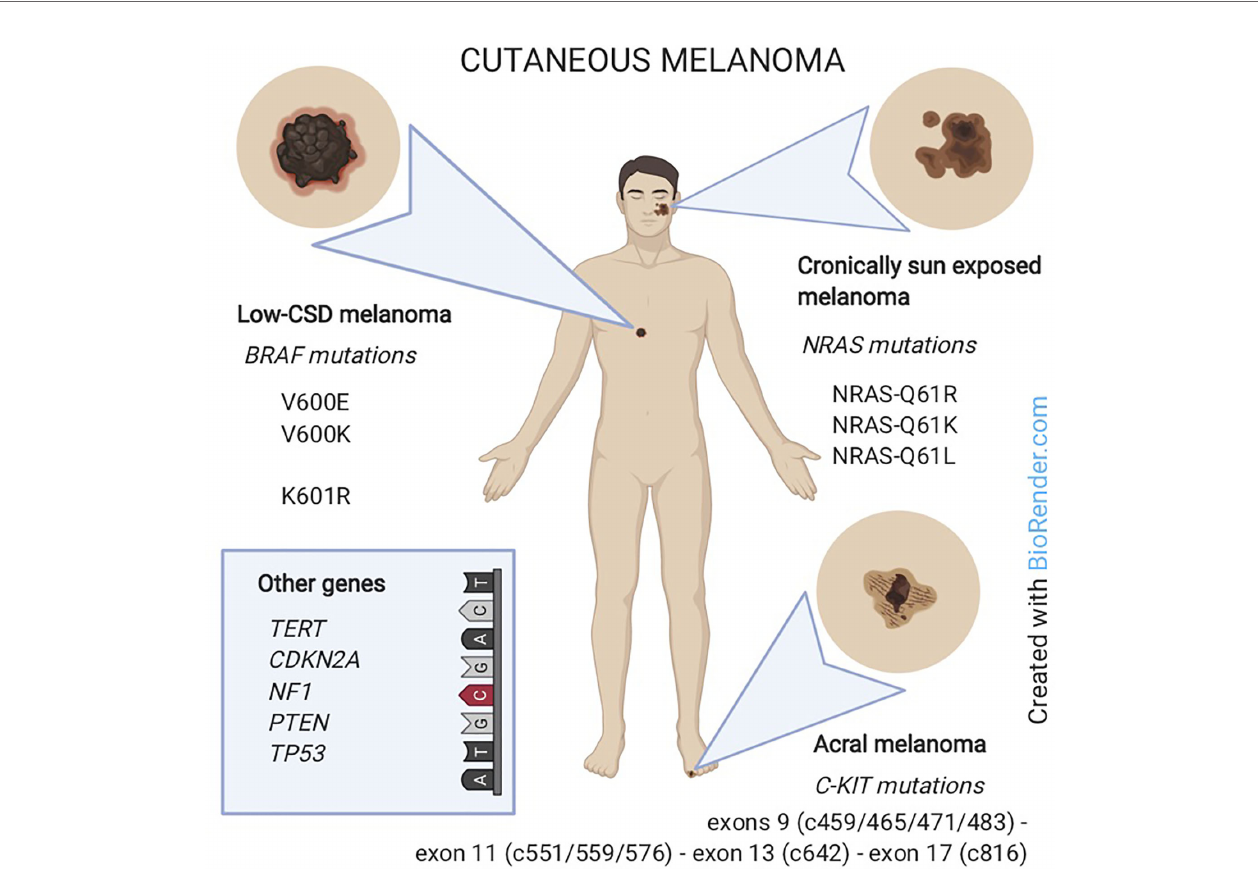
FIGURE 3 | Melanoma classi fi cation according to the association with sun-exposure and genomic features. Low-CSD melanoma (mainly on the trunk) carries BRAF mutations. Melanoma in chronically sun-exposed skin (in the head and neck region) carries NRAS mutations. Non-sun-related melanomas (on acral sites) carry C-KIT mutations. In rare cases, other genes as TERT , CDKN2A , NF1 , PTEN or TP53 are